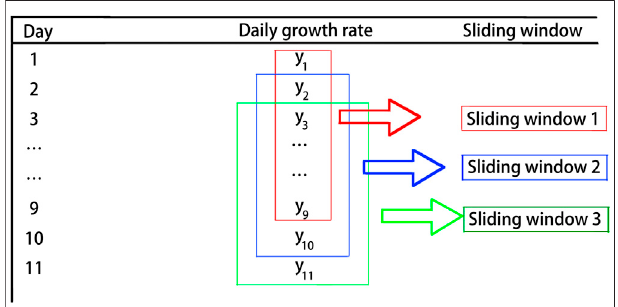
FIGURE1| Slidingwindowsareusedtoformthetimeseries.Thelength of sliding windows is chosen as 9 days, and the step size is 1 day. The fi gure shows the process of constructing time